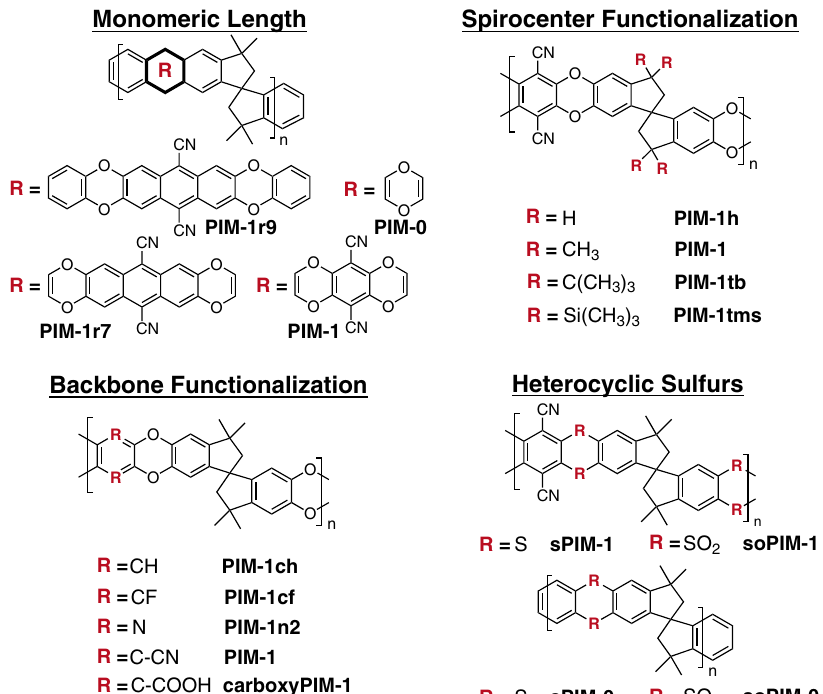
Fig. 8 Monomer units used to construct the 15 types of polymer of intrinsic microporosity models. Names of each polymer system are provided next to the associated R